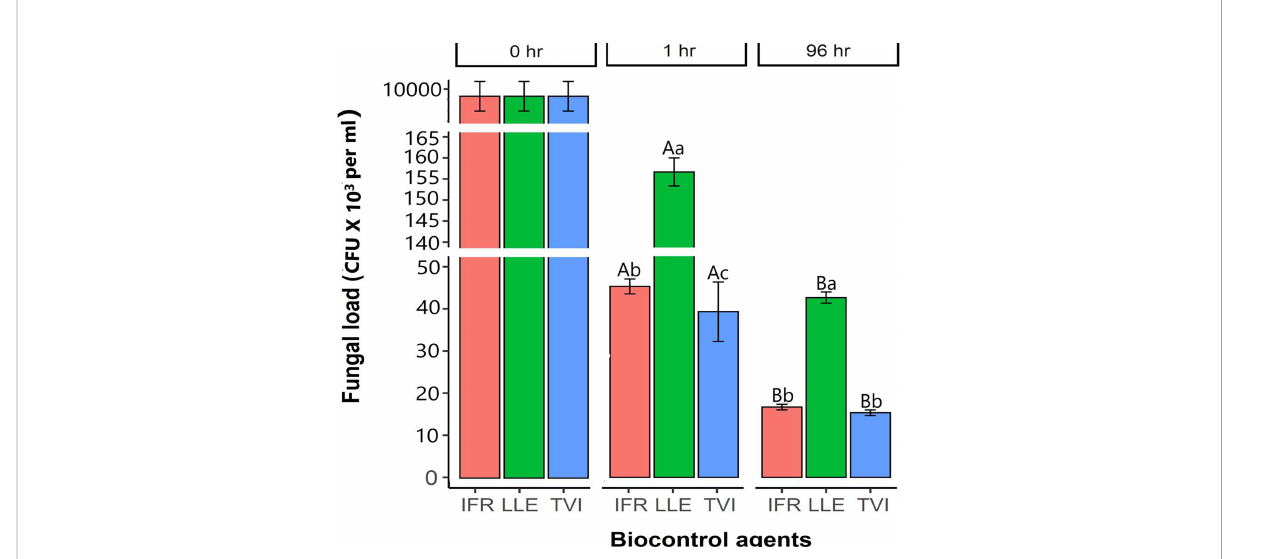
FIGURE 6 The comparisons of colony-forming units of the BCAs, L. attenuatum (LLA), I. Fumosorosea (IFR), and T. virens (TVI), inoculated into aquaponics water in decoupled aquaponics and 0.05% tween 80 solution. The CFUs per culture were counted after 24 to120 hrs of cultivation. Capital letters indicate a signi fi cant difference between 1 and 96 hrs, while the small letters indicate signi fi cant differences within the time points (1 and 96 hrs). The vertical bars are the mean ± SE (n = 3). The different letters indicate that values are signi fi cantly different at P< 0.05 according to the Least Signi fi cance Difference